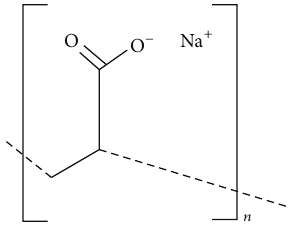
Figure 1: Structure of sodium polyacrylate.